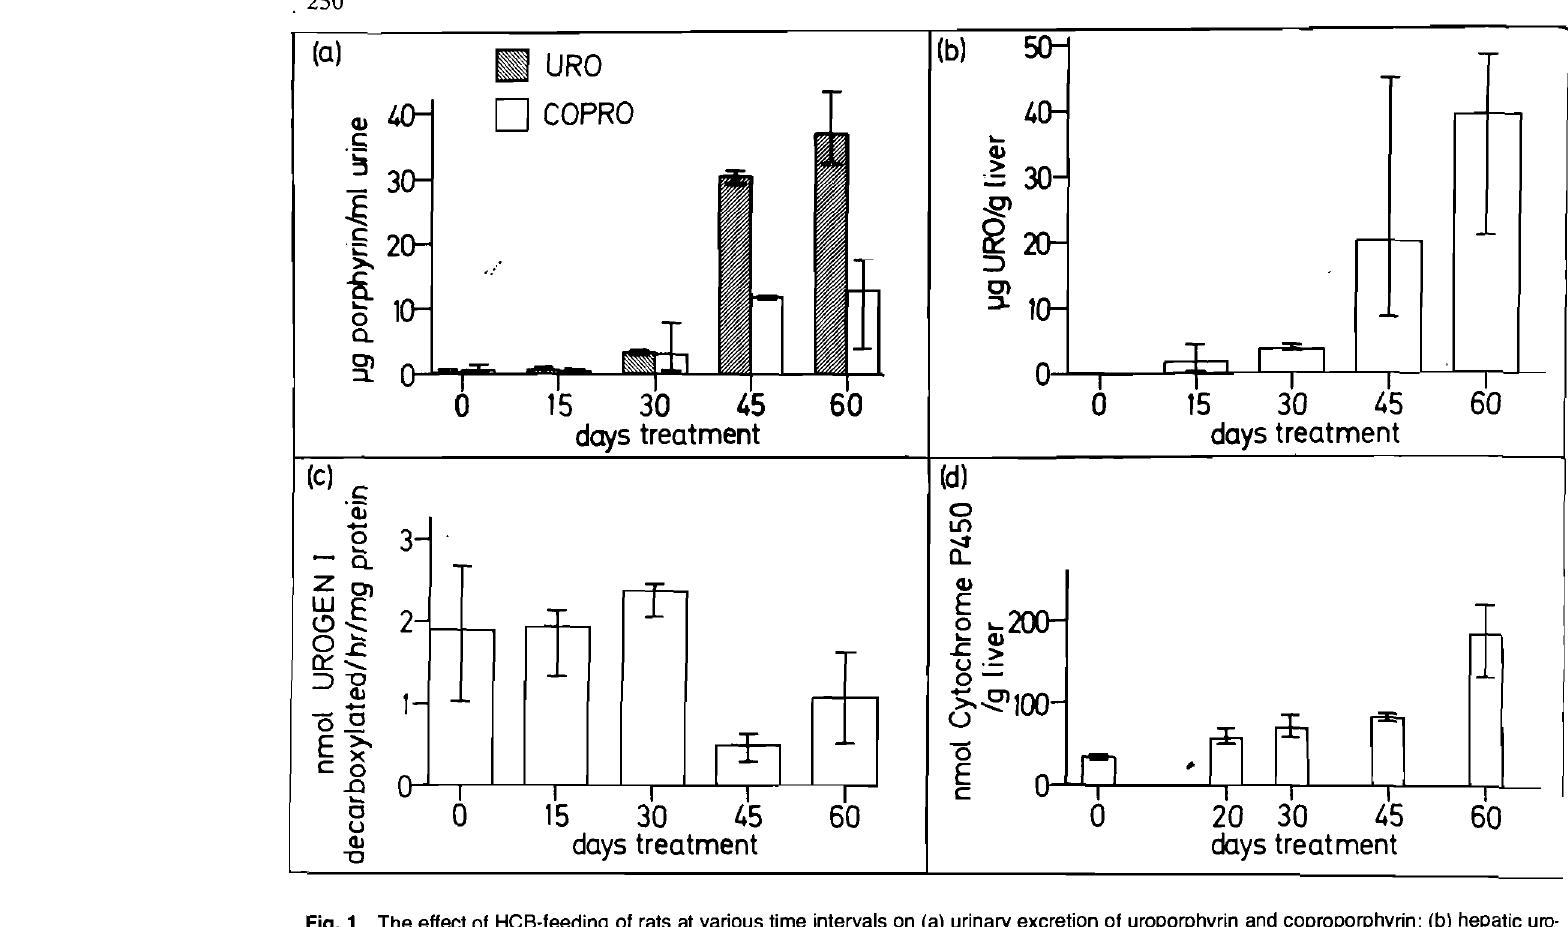
Fig. 1 The effect of HCB-feeding of rats at various time intervals on (a) urinary excretion of uroporphyrin and coproporphyrin; (b) hepatic uro· porphyrin content; (c) hepatic uroporphyrinogen I decarboxylase activity, and (d) hepatic cytochrome P450 content. Histograms indicate the means from 3 observations, with bars indicating the range of values. URO = Uroporphyrin; COPRO = Coproporphyrin; UROGEN = Uropor phyrinogen decarboxylase